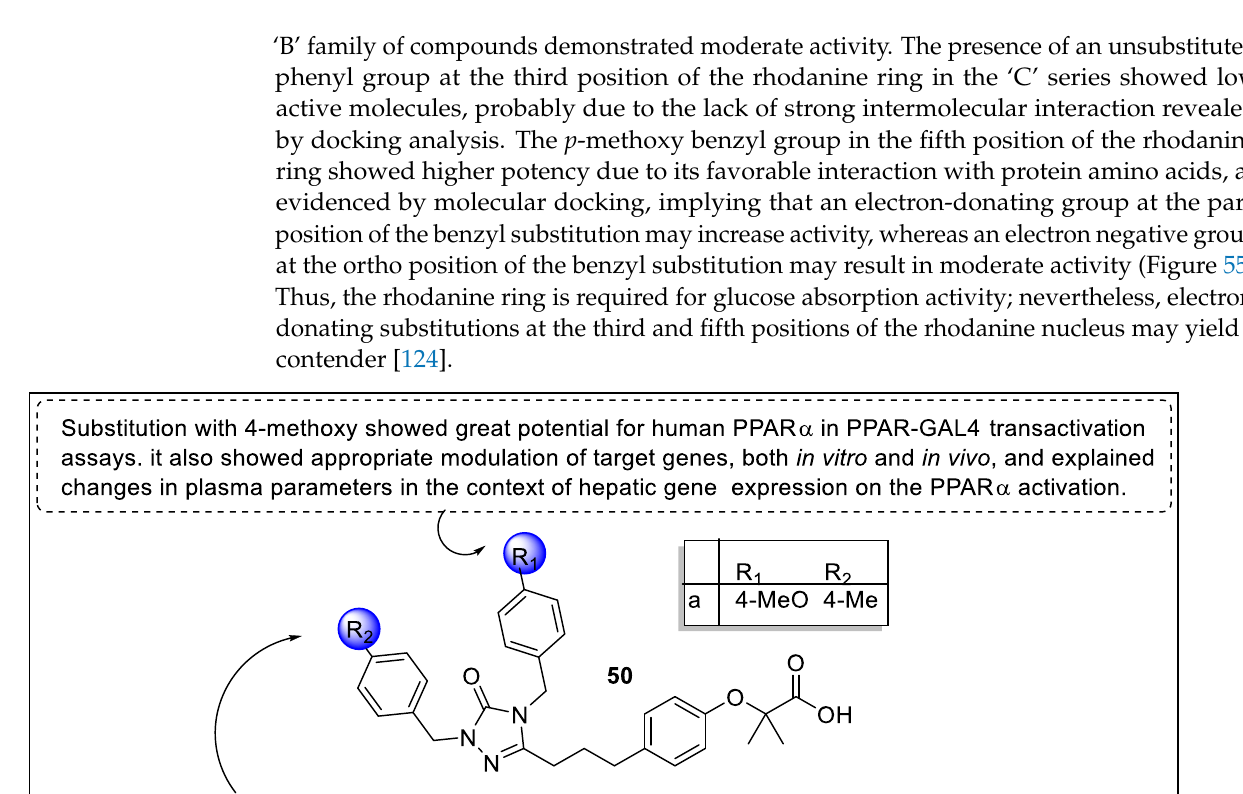
Figure 53. Structural activity relationship of quinoxaline hybrids ( 49 ) as potent PPAR ligands.